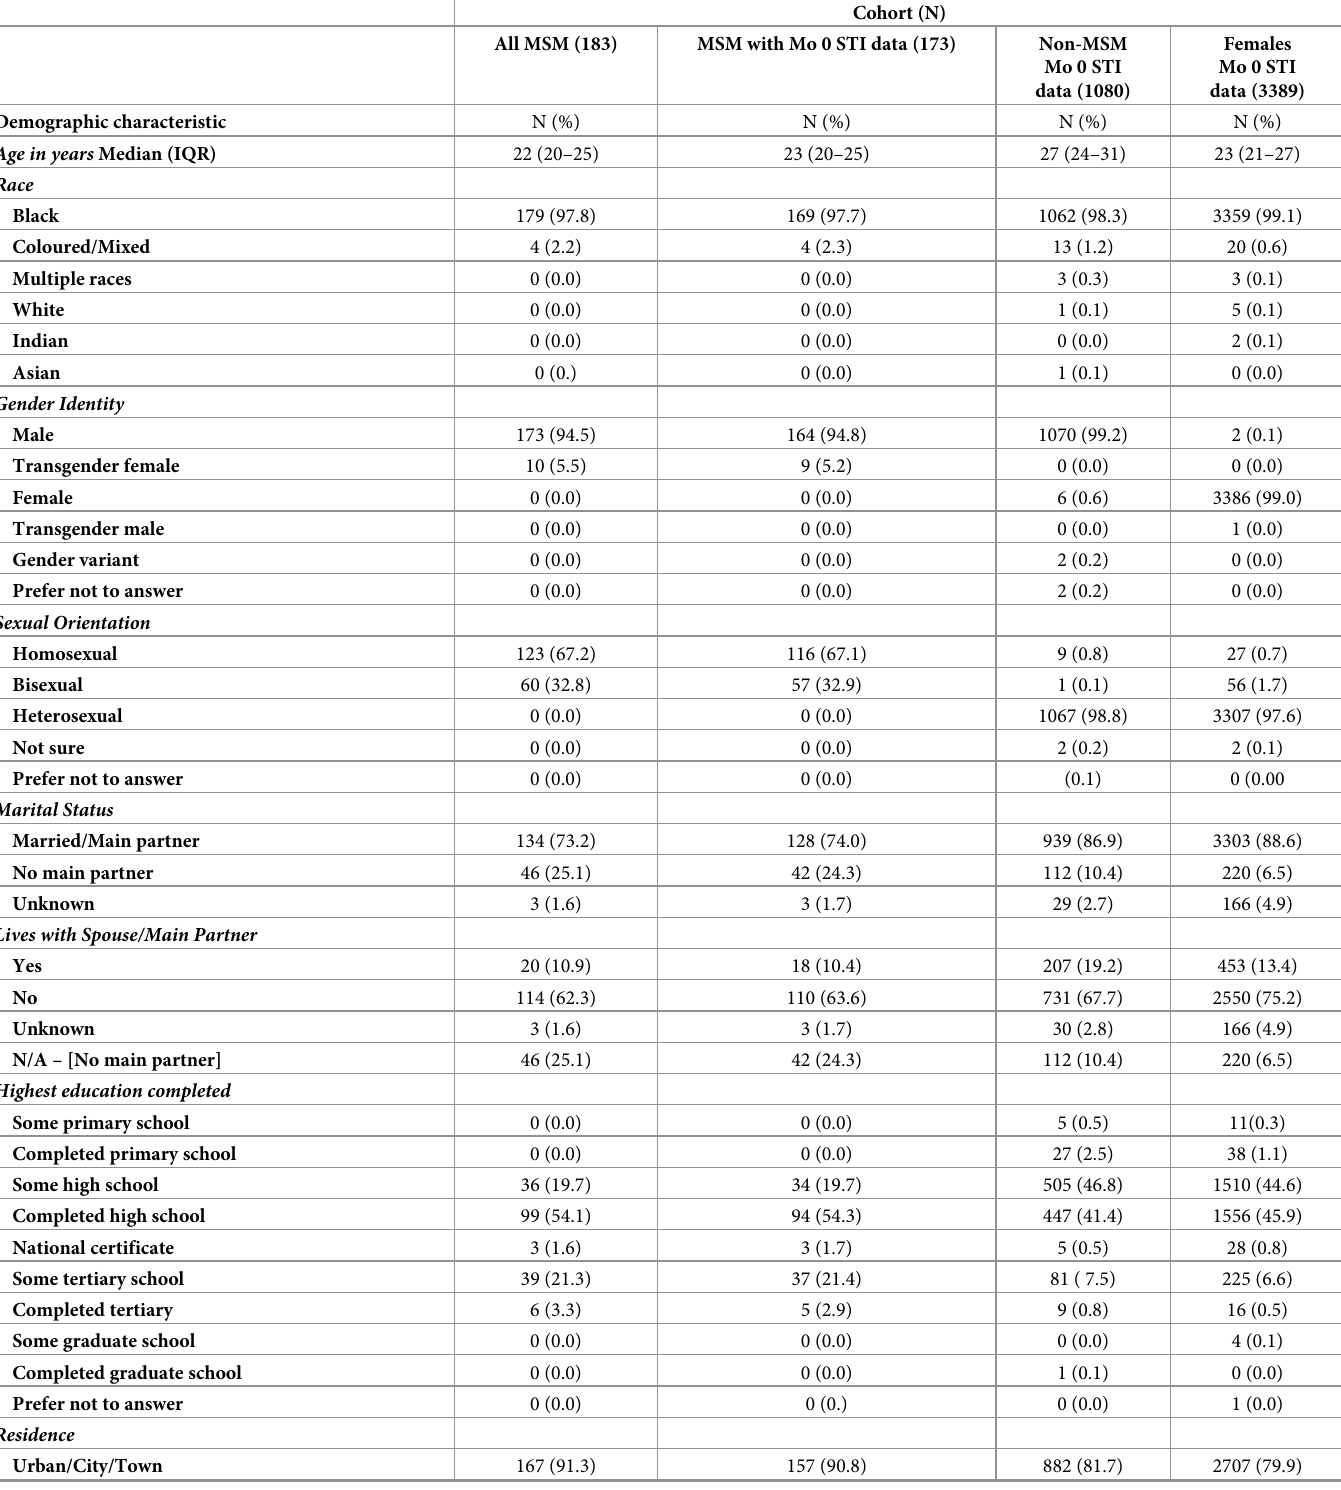
Table 1. Demographic and sexual characteristics for all MSM participants and MSM, non-MSM male and Female participants who had STI data available at Month